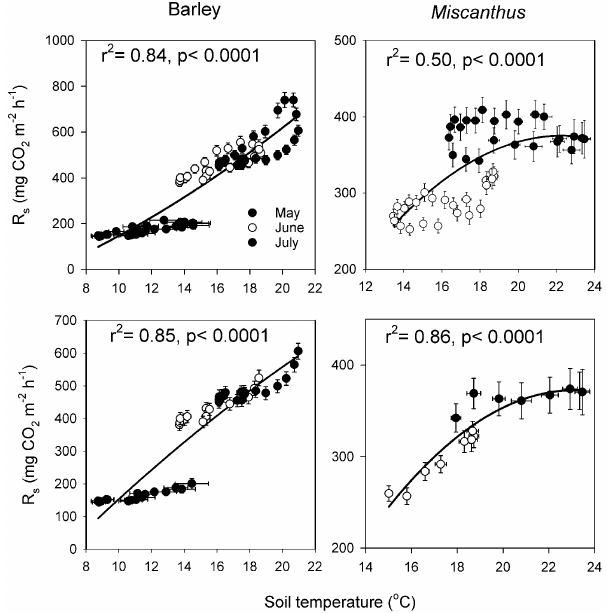
Figure 4. Regression models of monthly mean average hourly ( ± 1SE, n = 6) flux R s and soil temperature at 5cm depth for barley (left column) and Miscanthus (right column). Data shown include full 24h period (top row) and only data from the typical manual measurement window of 09:00–16:00 (bottom row). Soil tempera- ture data were not available for Miscanthus during